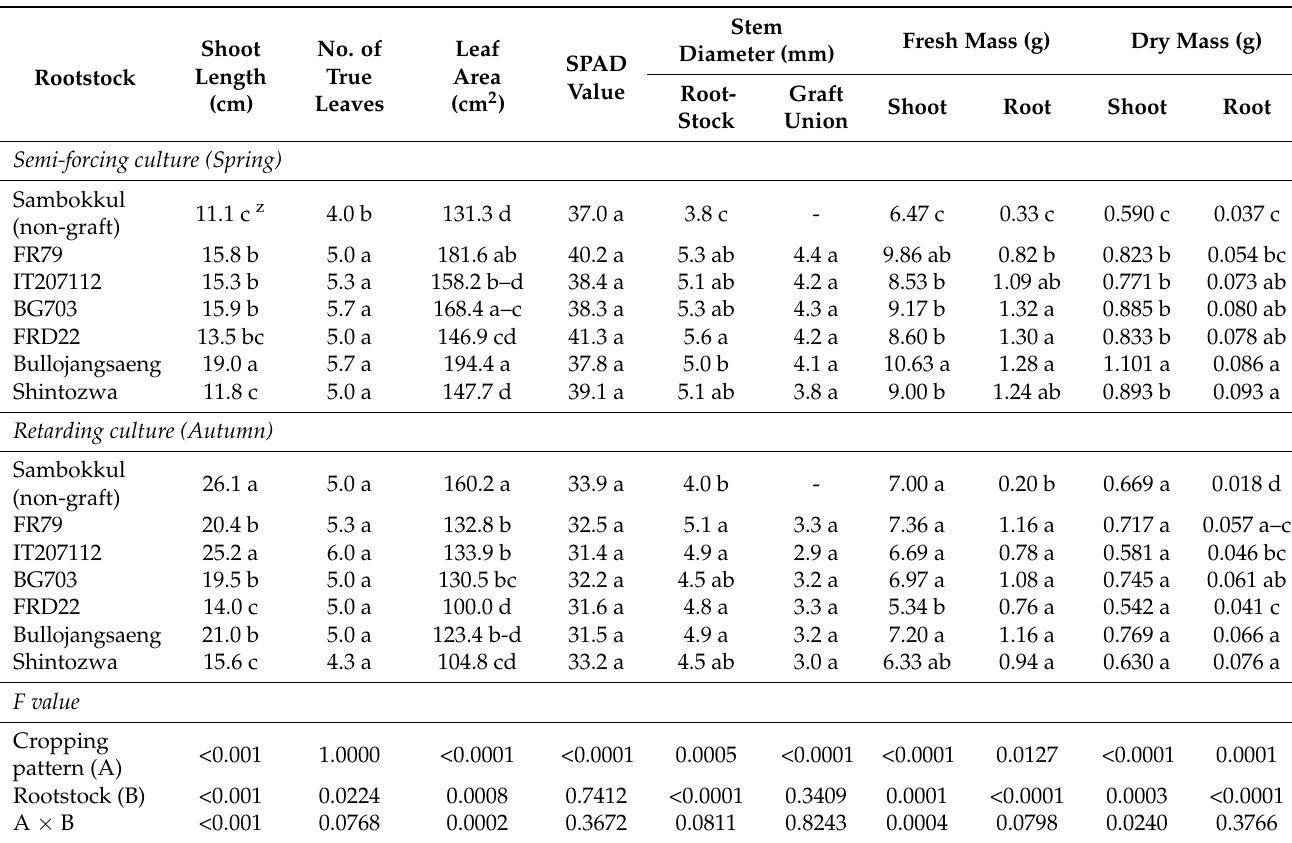
Table 3. The growth of watermelon transplants influenced by bottle gourd rootstock accessions before transplanting.